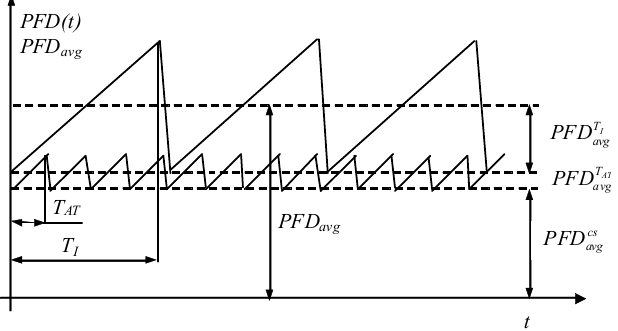
Figure 18. Elements of the average probability of an E/E/PE subsystem failure on demand.